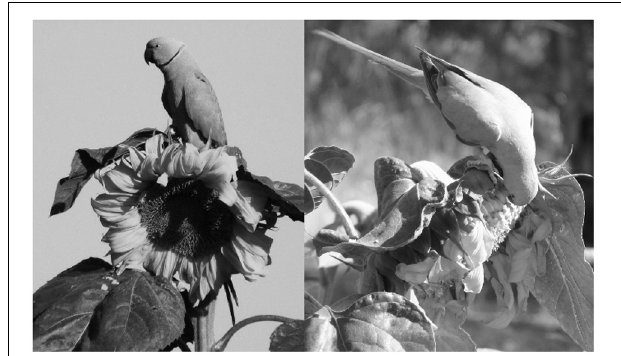
FIGURE 1 | Rose-Ringed Parakeets ( Psittacula krameri Scopoli) resting on a sunflower and feeding on sunflower seeds in the field used for the field-scale